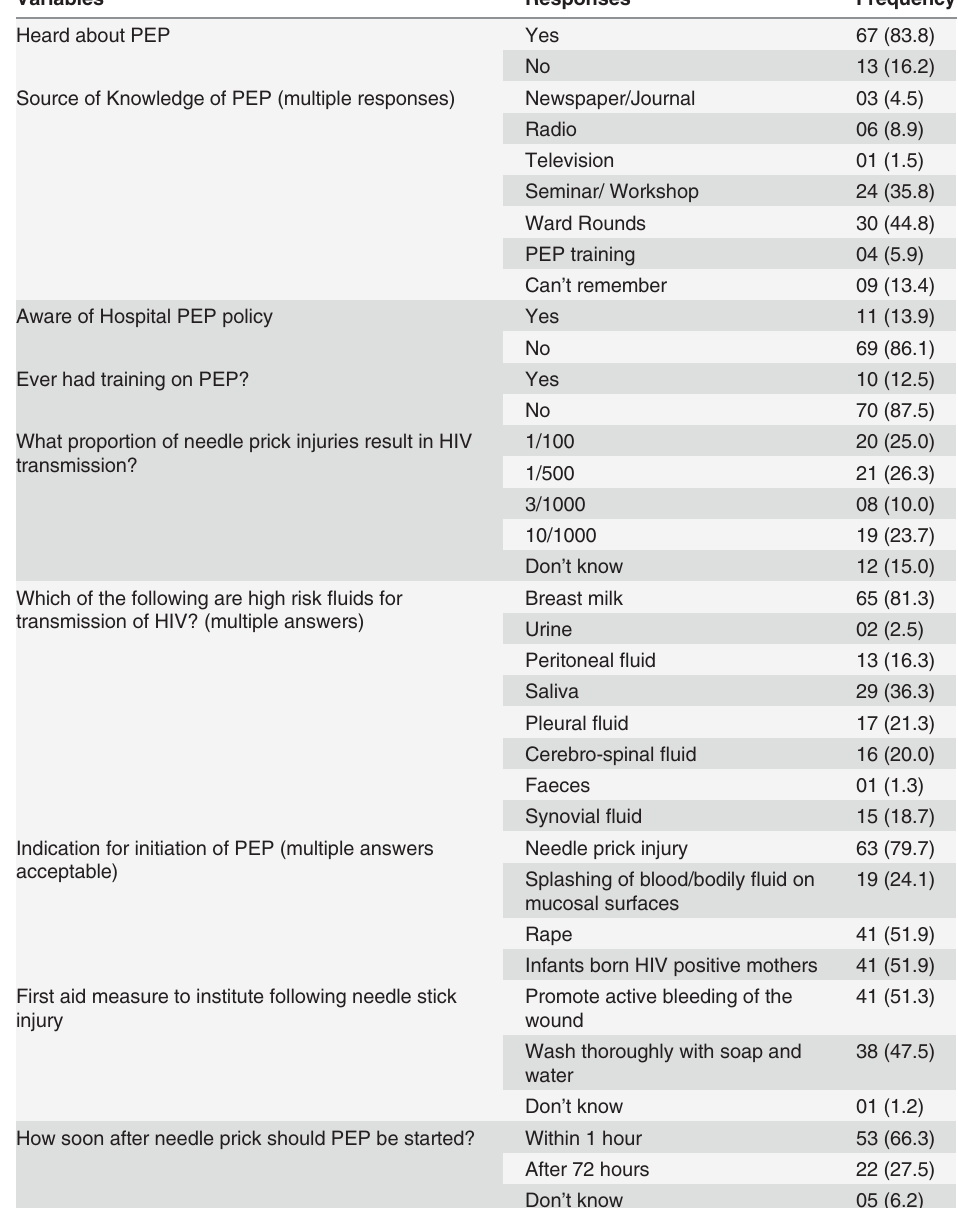
Table 2. Knowledge about PEP for HIV among Nurses in Tubah Health District,